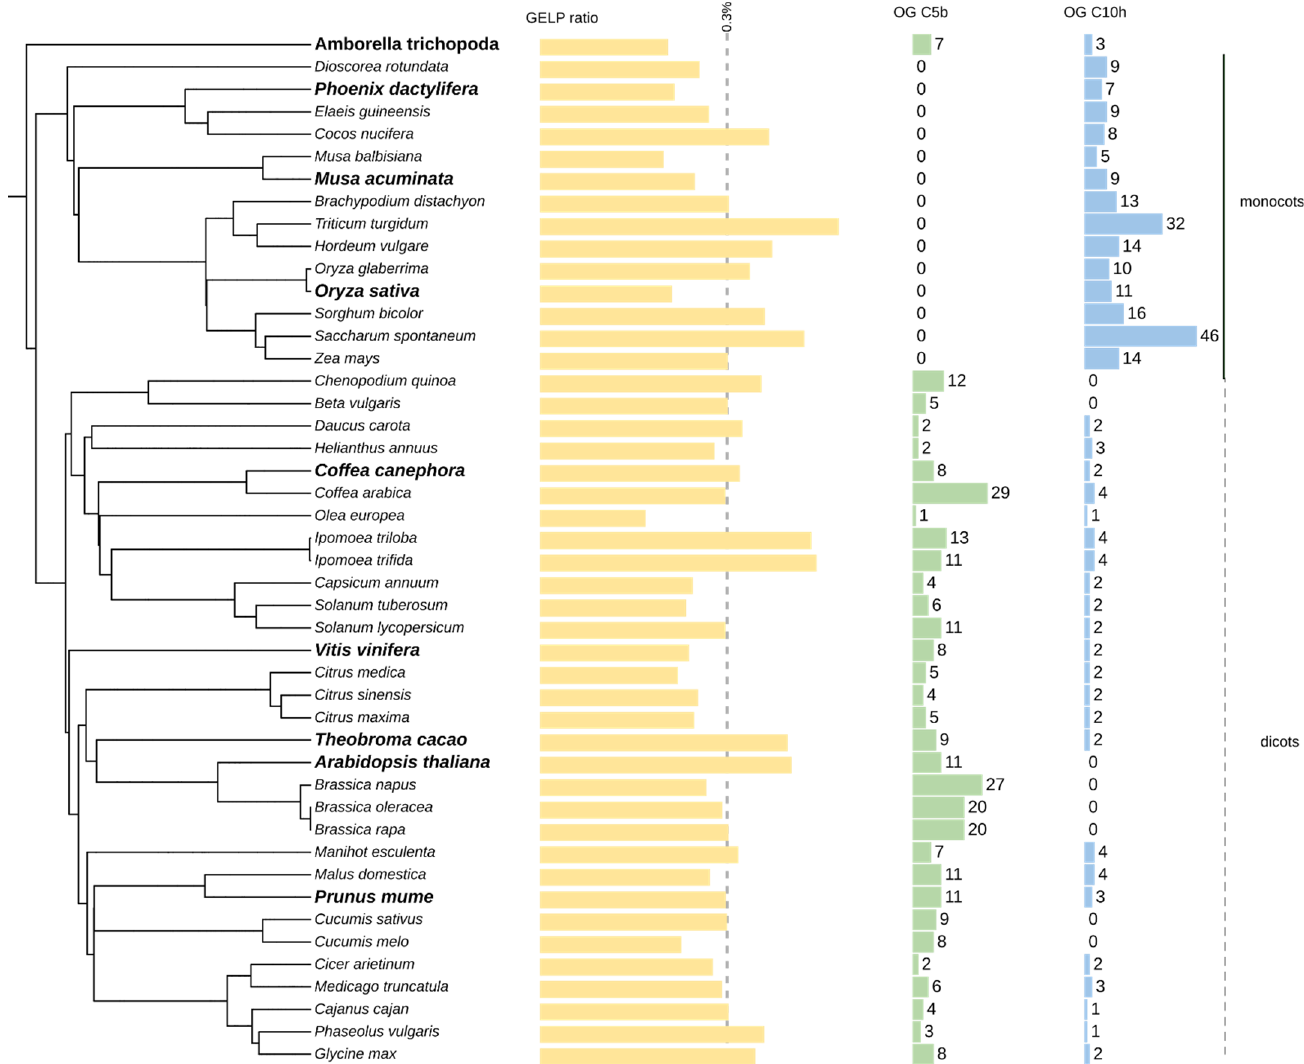
Figure 3. GELP gene distribution in 46 plant species. The species selected for the curated data set are in bold. The GELP bar char indicates the percentage of GELP genes in each species (mean = 0.32%). Other bar charts represent the number of genes in selected orthogroups (OG). As previously detected in the core set, five dicot-specific orthogroups (OG-GELP- C4f, C5b, C7f, C8c and C10c) were confirmed. Orthogroups with expansion in monocots were also observed (OG-GELP-C4h, OG-GELP-C4i and OG-GELP-C10f).